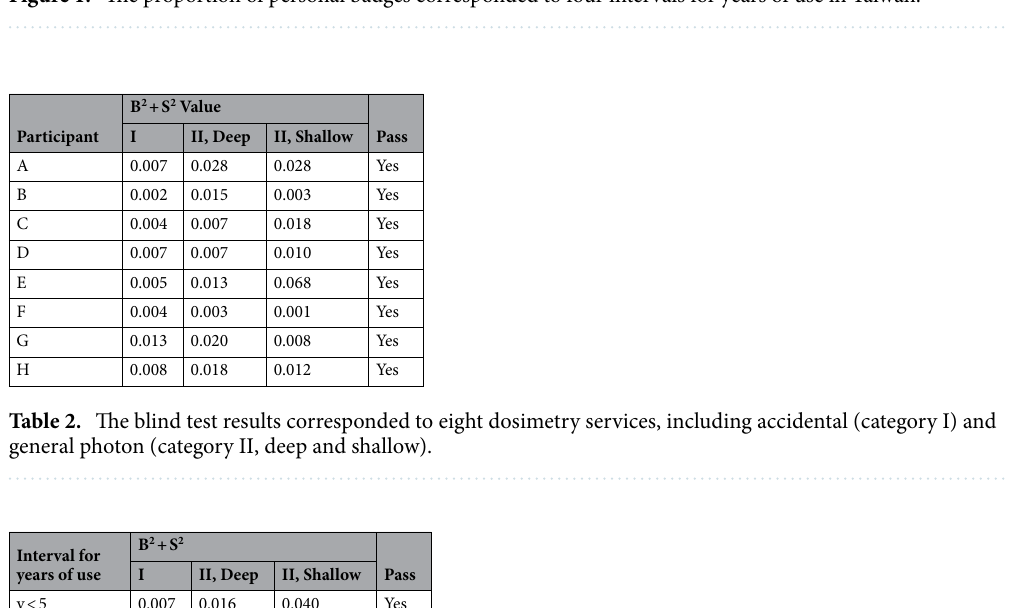
Figure 1. The proportion of personal badges corresponded to four intervals for years of use in Taiwan.